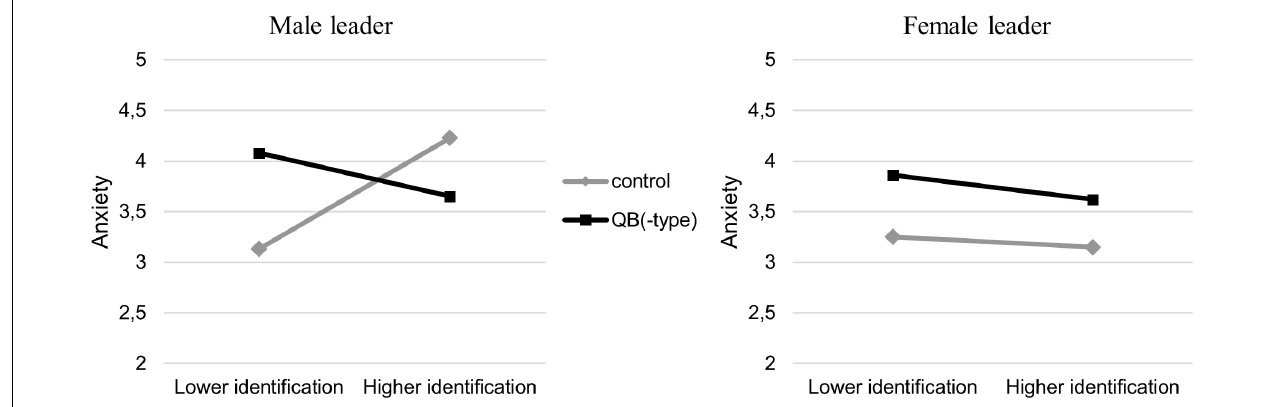
FIGURE 2 | Simple slopes showing anxiety as a function of leader behavior (QB[-type] vs. control) and gender identification (–1 SD, +1 SD) in the male leader and in the female leader